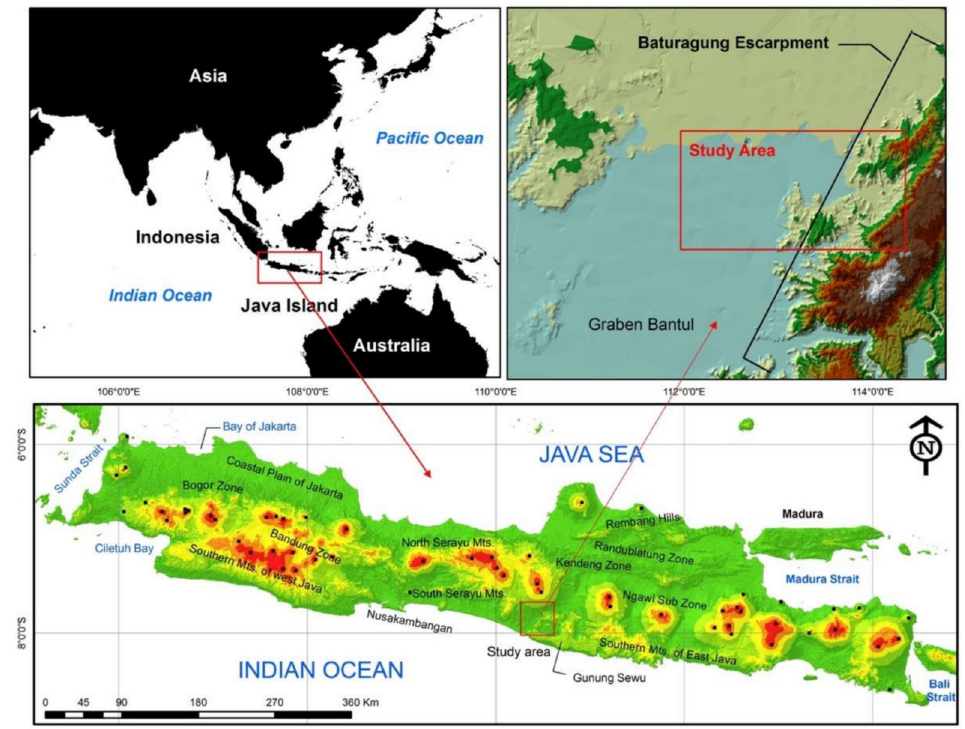
Figure 1. The location of study